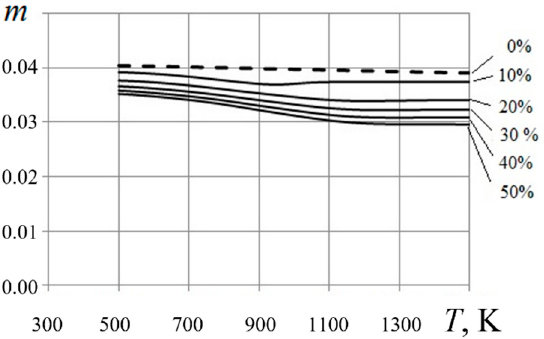
Figure 8. Calculated dependences of coefficient m on temperature for PP–air mixtures with different content of PP (mass basis) at pressure 1 MPa.